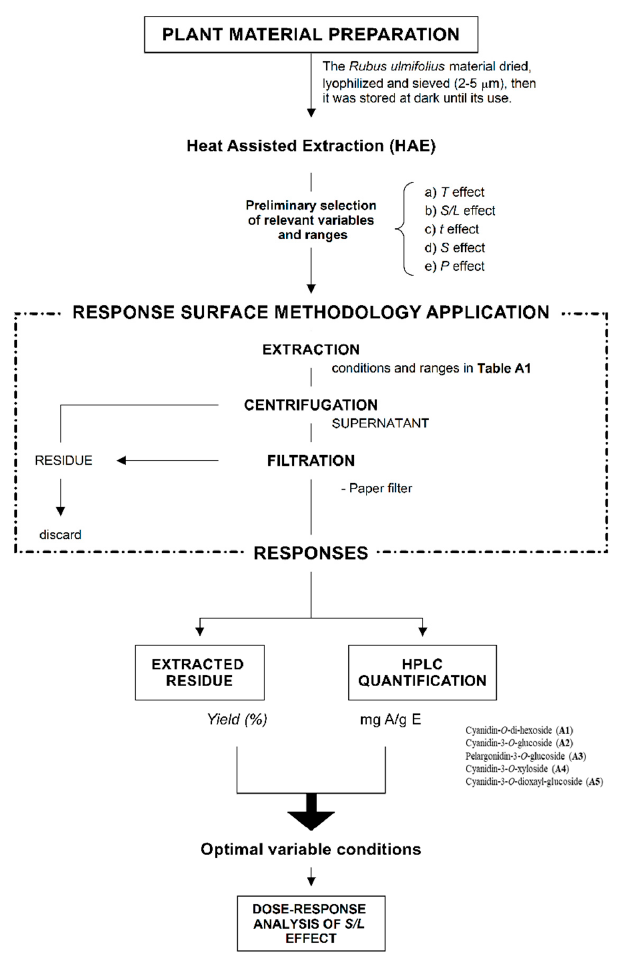
Figure 3. Diagram of the different steps carried out for optimizing the conditions that maximize the extraction responses.